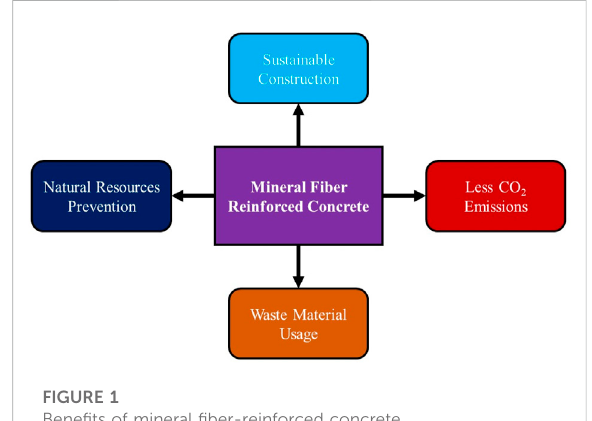
Bene fi ts of mineral fi ber-reinforced